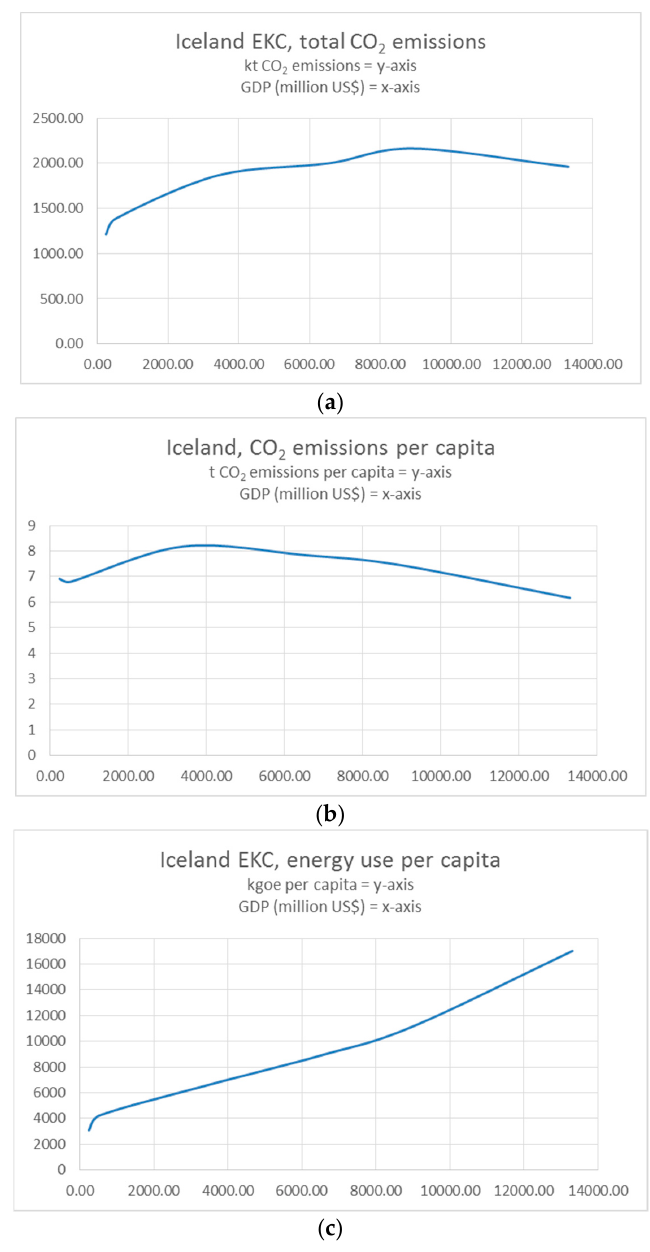
Figure 7. Analysis of the EKC for Iceland. Data source: [44]. ( a ) Iceland EKC, total CO 2 emissions; ( b ) Iceland EKC, CO 2 emissions per capita; ( c ) Iceland EKC, energy use per capita.